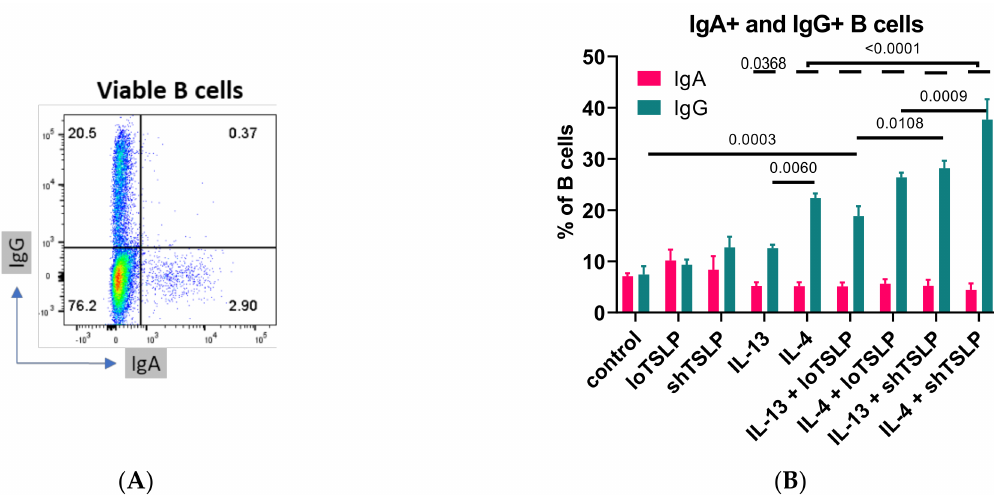
Figure 3. Flow cytometric analysis of B cells after 7 days of stimulation. An example of IgG and IgA flow cytometric analysis ( A ) and summarized data showing mean and standard error of the mean ( B ) of 4–5 donors are shown from two independent experiments. The overlaying bar indicates that the differences of the five small bars are all p < 0.0001. ANOVA with Sidaks correction for multiple testing was used.